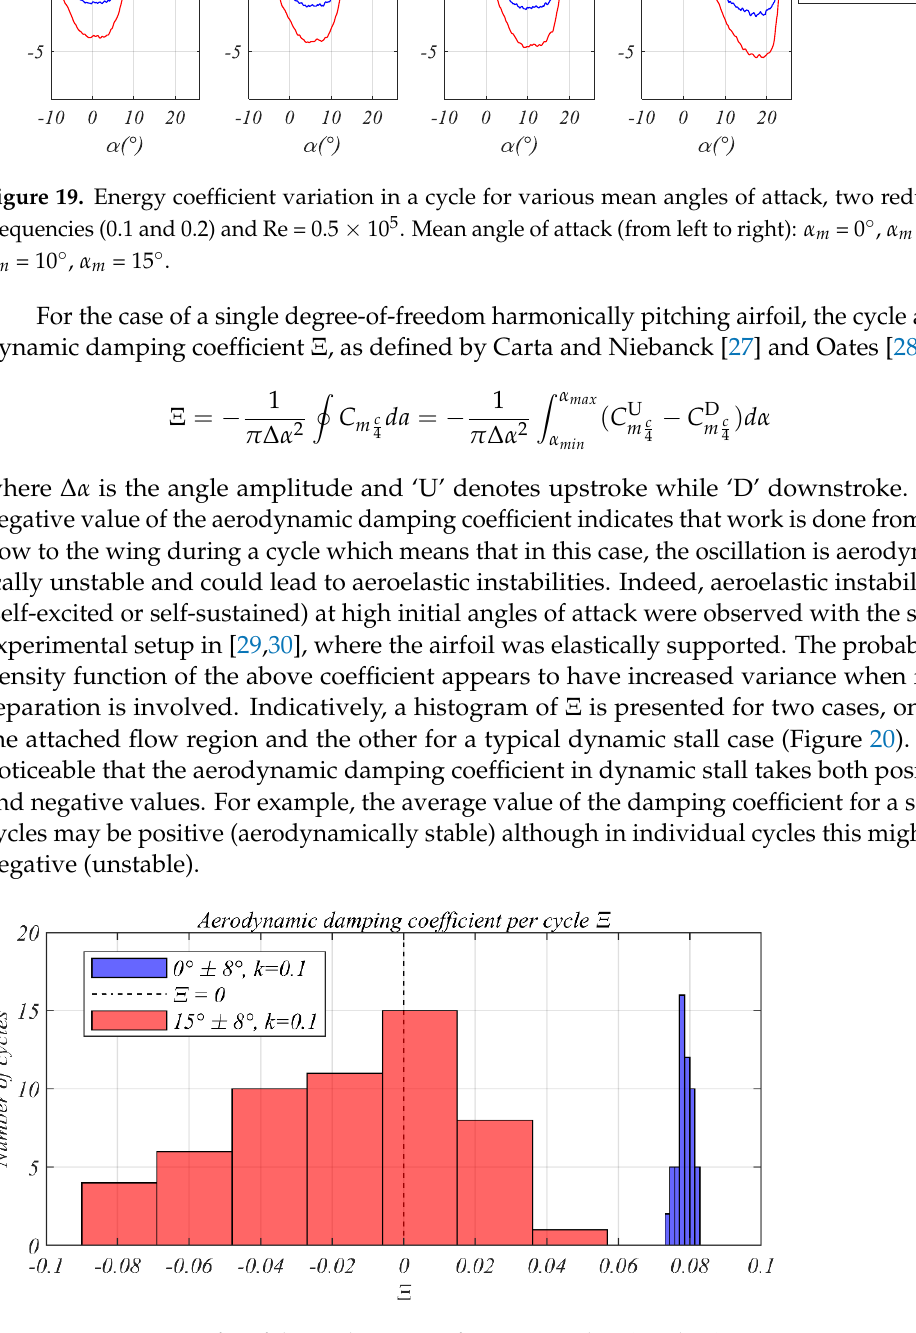
Figure 20. Histogram of Ξ of the pitching wing for mean angles 0° and 15°.